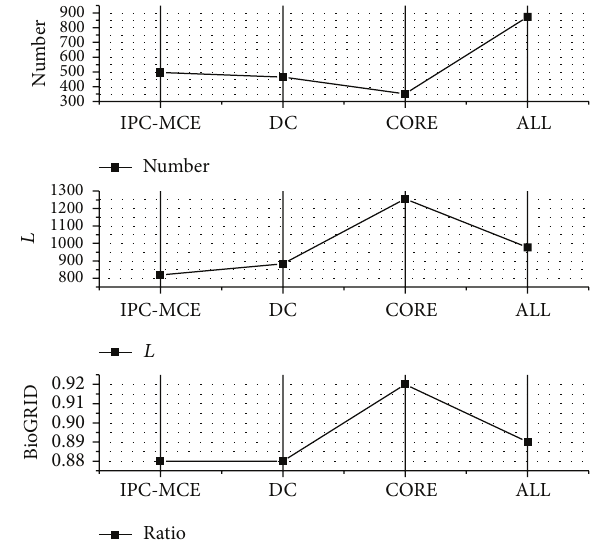
Figure 3: ALL has the largest number of predicted pairs. The estimation results with value 𝐿 and BioGRID are better than the other compared methods. CORE has the largest accurate but small number. These predictions in CORE pursue high quality by sacrificing the predicted